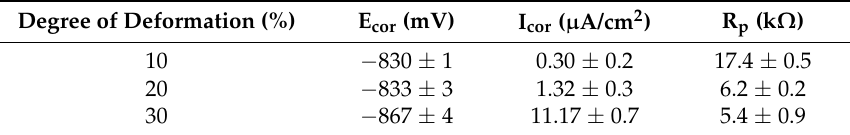
Figure 11. Polarization curves of the alloy after the LTTT with plastic deformation of 10%, 20%, and 30%. Table 2. Electrochemical parameters obtained from cyclic polarization